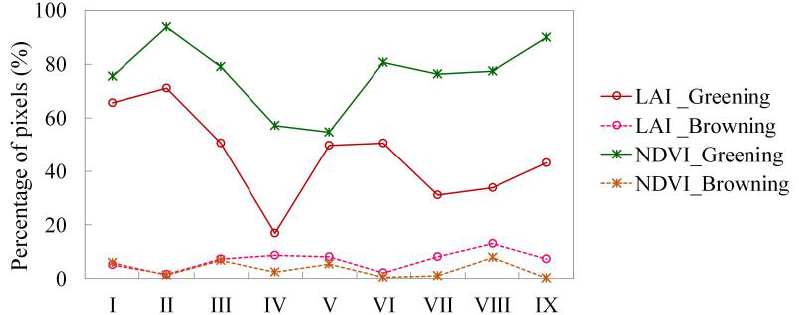
Figure 7. Percentage of cropland pixels with greening and browning in nine major Chinese agricultural zones from 1982 to 2015.